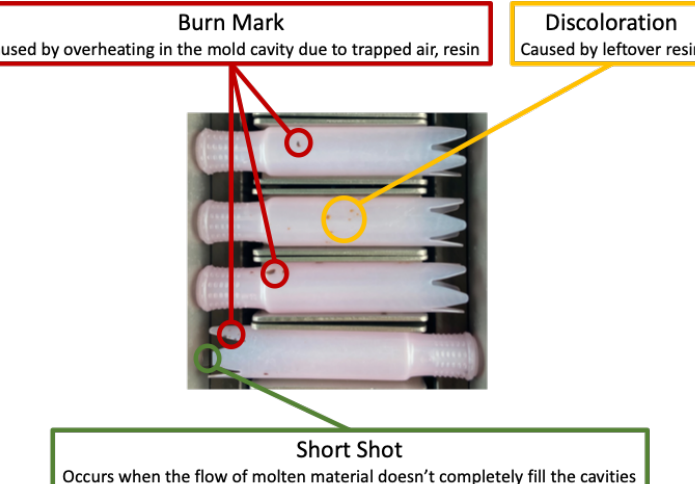
Figure 2. Common defect types of tampon